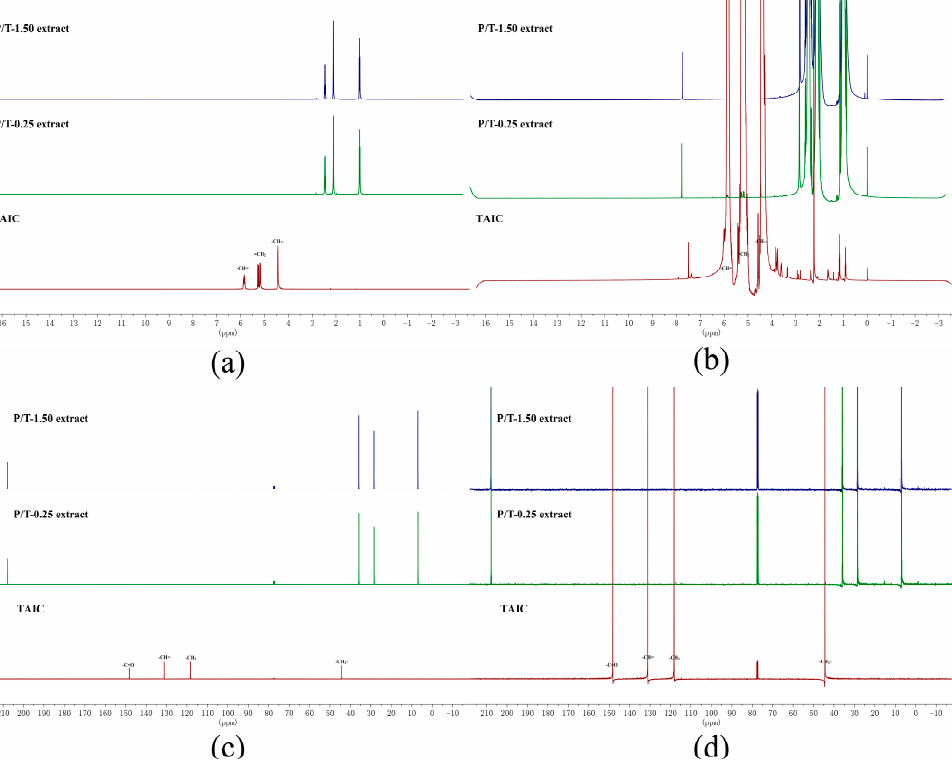
Figure 6. ( a ) Chromatograms of extracts from P/T-0.25 and P/T-1.50; ( b ) HPLC chromatograms of TAIC/MEK solution with different TAIC mass fractions; ( c ) TAIC calibration curve. The abscissa was the detected TAIC quality, and the ordinate was the area of TAIC peak.